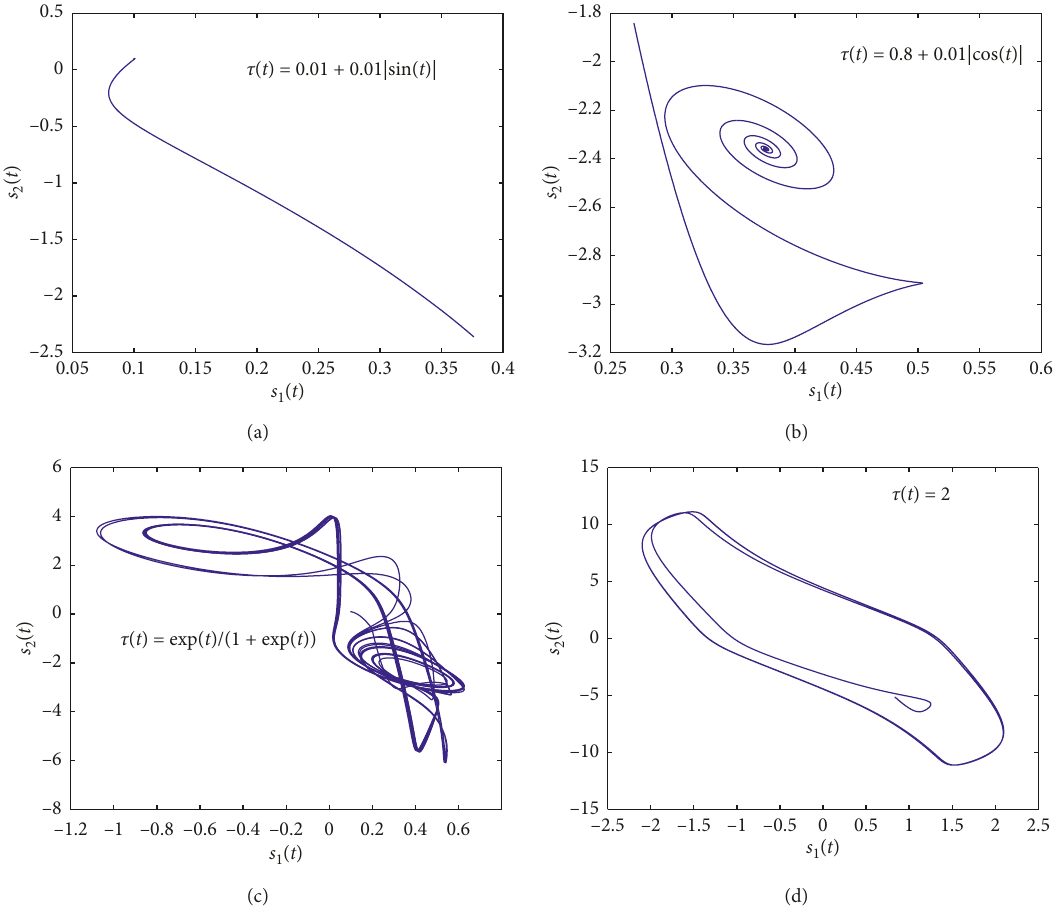
Figure 2: Different behaviors of s ( t ) with different time